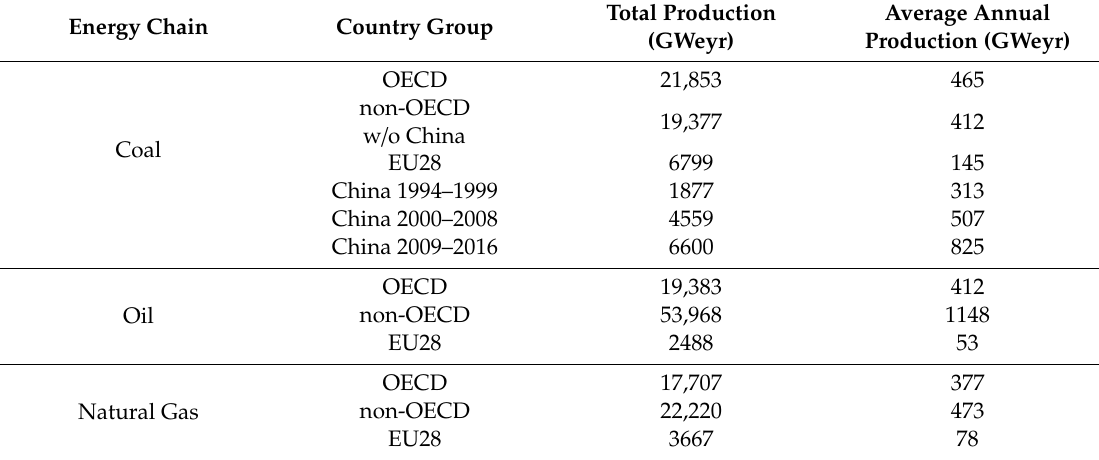
Table 2. Overview of the total and average annual production (GWeyr) for the analyzed energy chains and country groups for the years 1970–2016 [52]. In this study, the average annual production is used for normalization